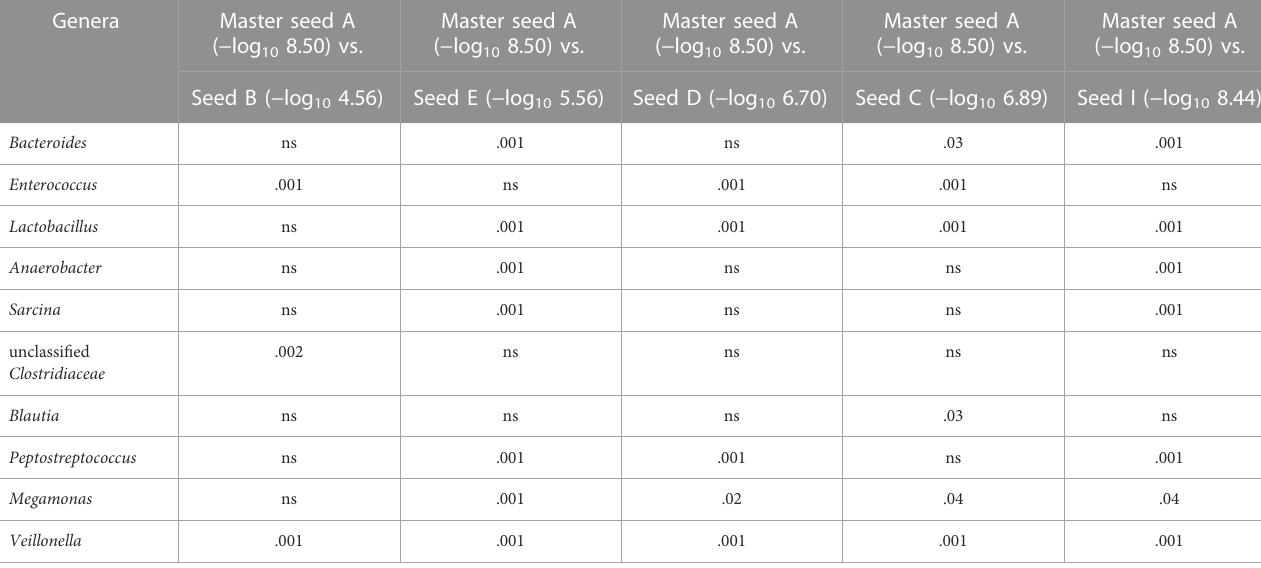
TABLE 6 Genera shared with the master competitive exclusion stock with seeds as determined by chi-square test.